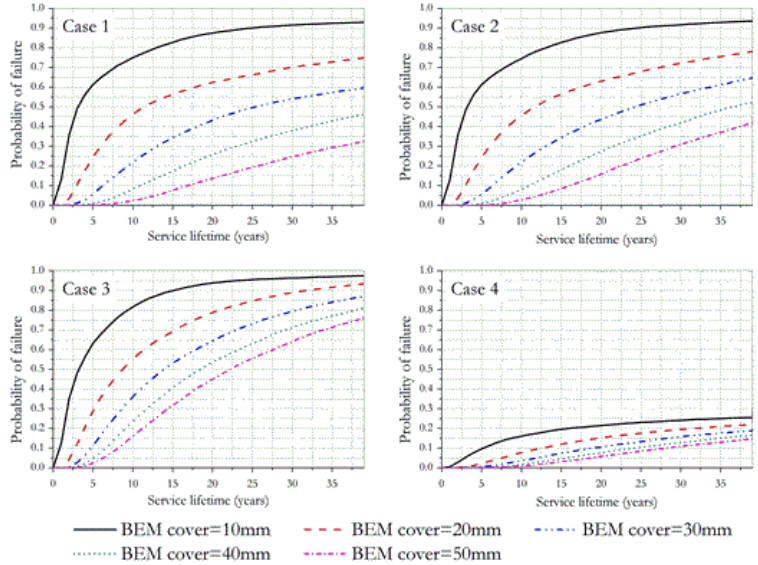
Figure 10 – Evolution of the probability of failure along